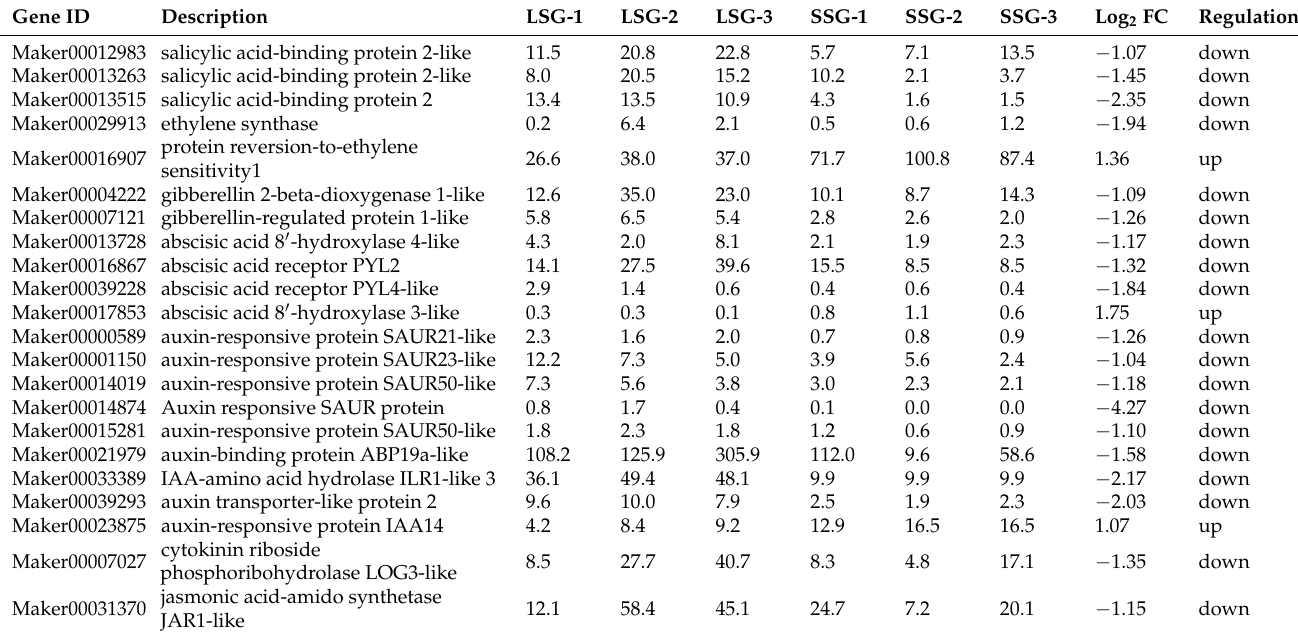
Table 4. Differentially expressed genes associated with plant hormone metabolism.